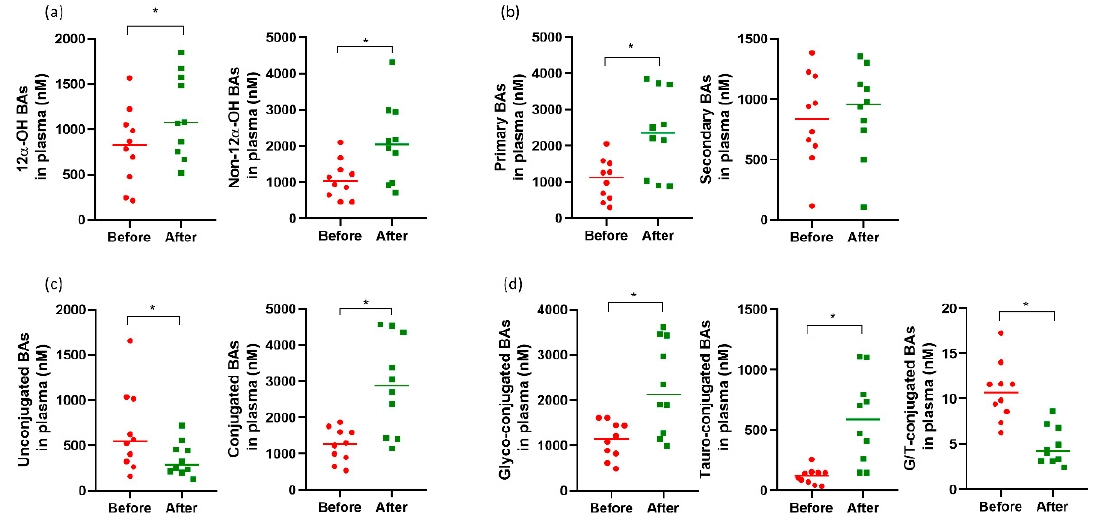
Figure 3. Changes in the composition of bile acids (BAs) of various categories in plasma before and after treatment with YH1. The concentrations of classified BAs in plasma before (red circles) and after (green squares) YH1 treatment in the ten patients are shown as scatter plots, with lines representing median values. Statistical differences (* p < 0.05) were detected by the Wilcoxon signed-rank test. After four weeks of YH1 treatment, the levels of ( a ) 12 α -hydroxylated BAs and non-12 α -hydroxylated BAs, ( b ) primary BAs, ( c ) conjugated BAs, and ( d ) glyco (G)- and tauro (T)-conjugated BAs in plasma were all significantly elevated. ( c ) Unconjugated BAs and ( d ) G/T ratio of conjugated BAs were significantly reduced. 12 α -OH BAs, 12 α -hydroxylated bile acids; Non-12 α -OH BAs, non-12 α -hydroxylated bile acids.